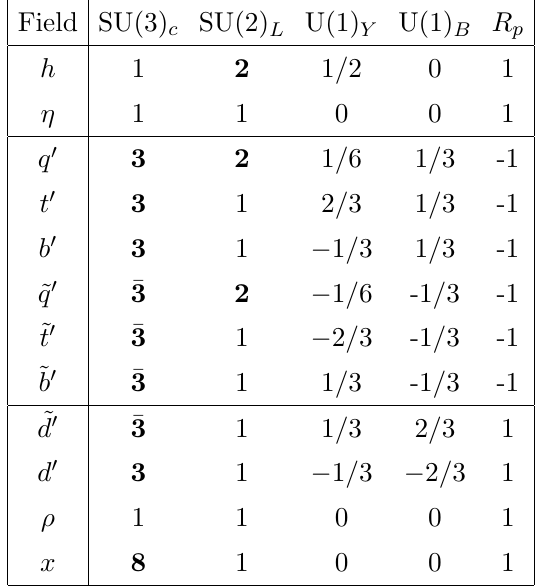
Table 5 . Spin-0 (cid:12)eld content of low-energy e(cid:11)ective theory.